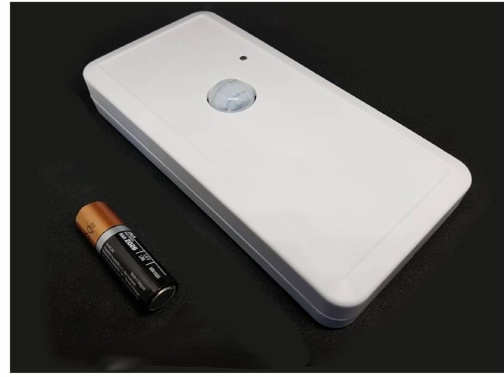
Figure 1. Picture of a fully-assembled Wi-Fi PIR